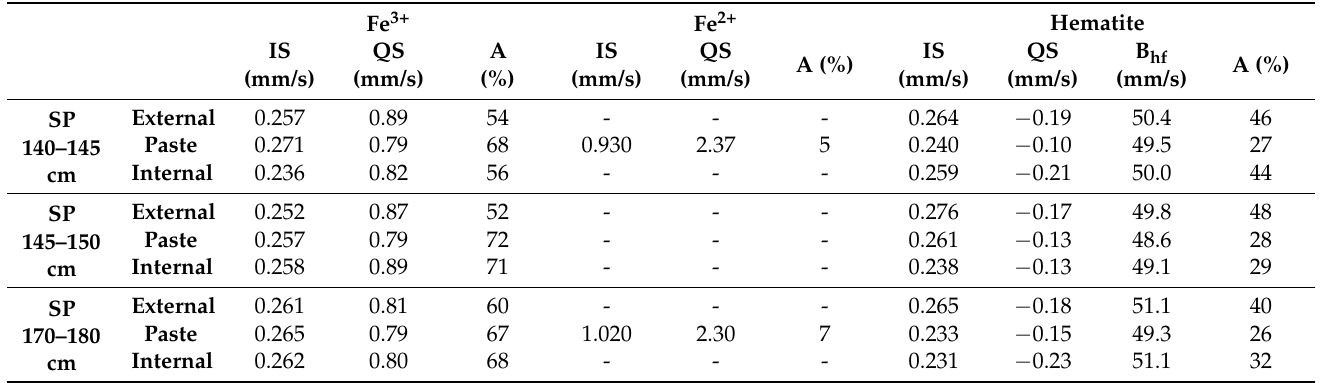
Table 2. Hyperfine parameters obtained at room temperature (IS: isomer shift; QS: